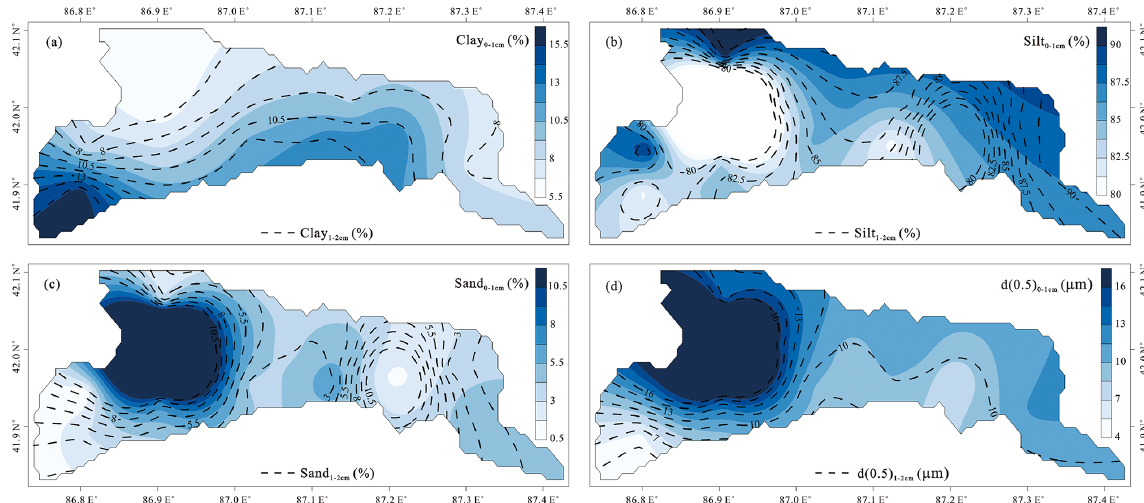
Figure 2. Distributions of (a) clay, (b) silt, (c) sand, and (d) the median diameter ( d (0.5),µm) in the 0–1cm (color map) and 1–2cm (dashed lines). The spatial distribution maps (Fig. 2–7) were produced using Surfer 9.0 (Golden Software Inc.), and the interpolated data in the maps were found using the kriging method of